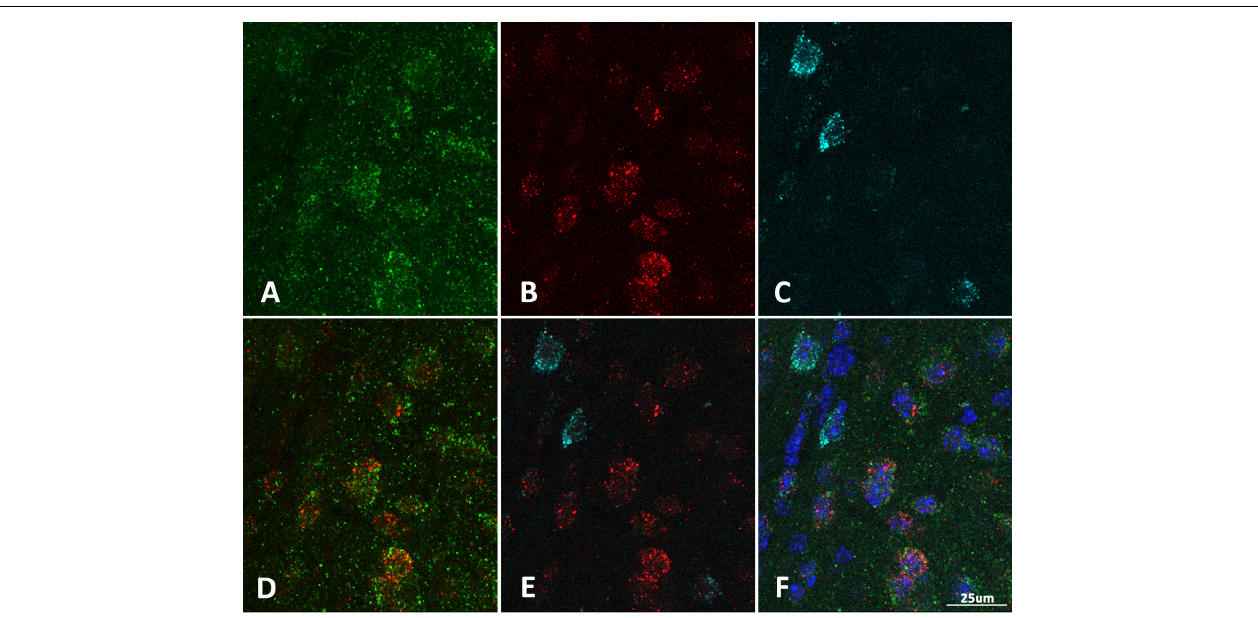
FIGURE 3 | Homer1a expression is localized to excitatory neurons in the claustrum. (A) Immunostain for CAMKII α (green); (B) Immunostain for Homer1a (red); (C) Immunostain for GAD67 (cyan); (D) CAMKII α and Homer1a overlap; (E) GAD67 and Homer1a merge; (F) Merge CAMKIII α , GAD67, Homer1a, and DAPI (blue). Bar size: 25 µ